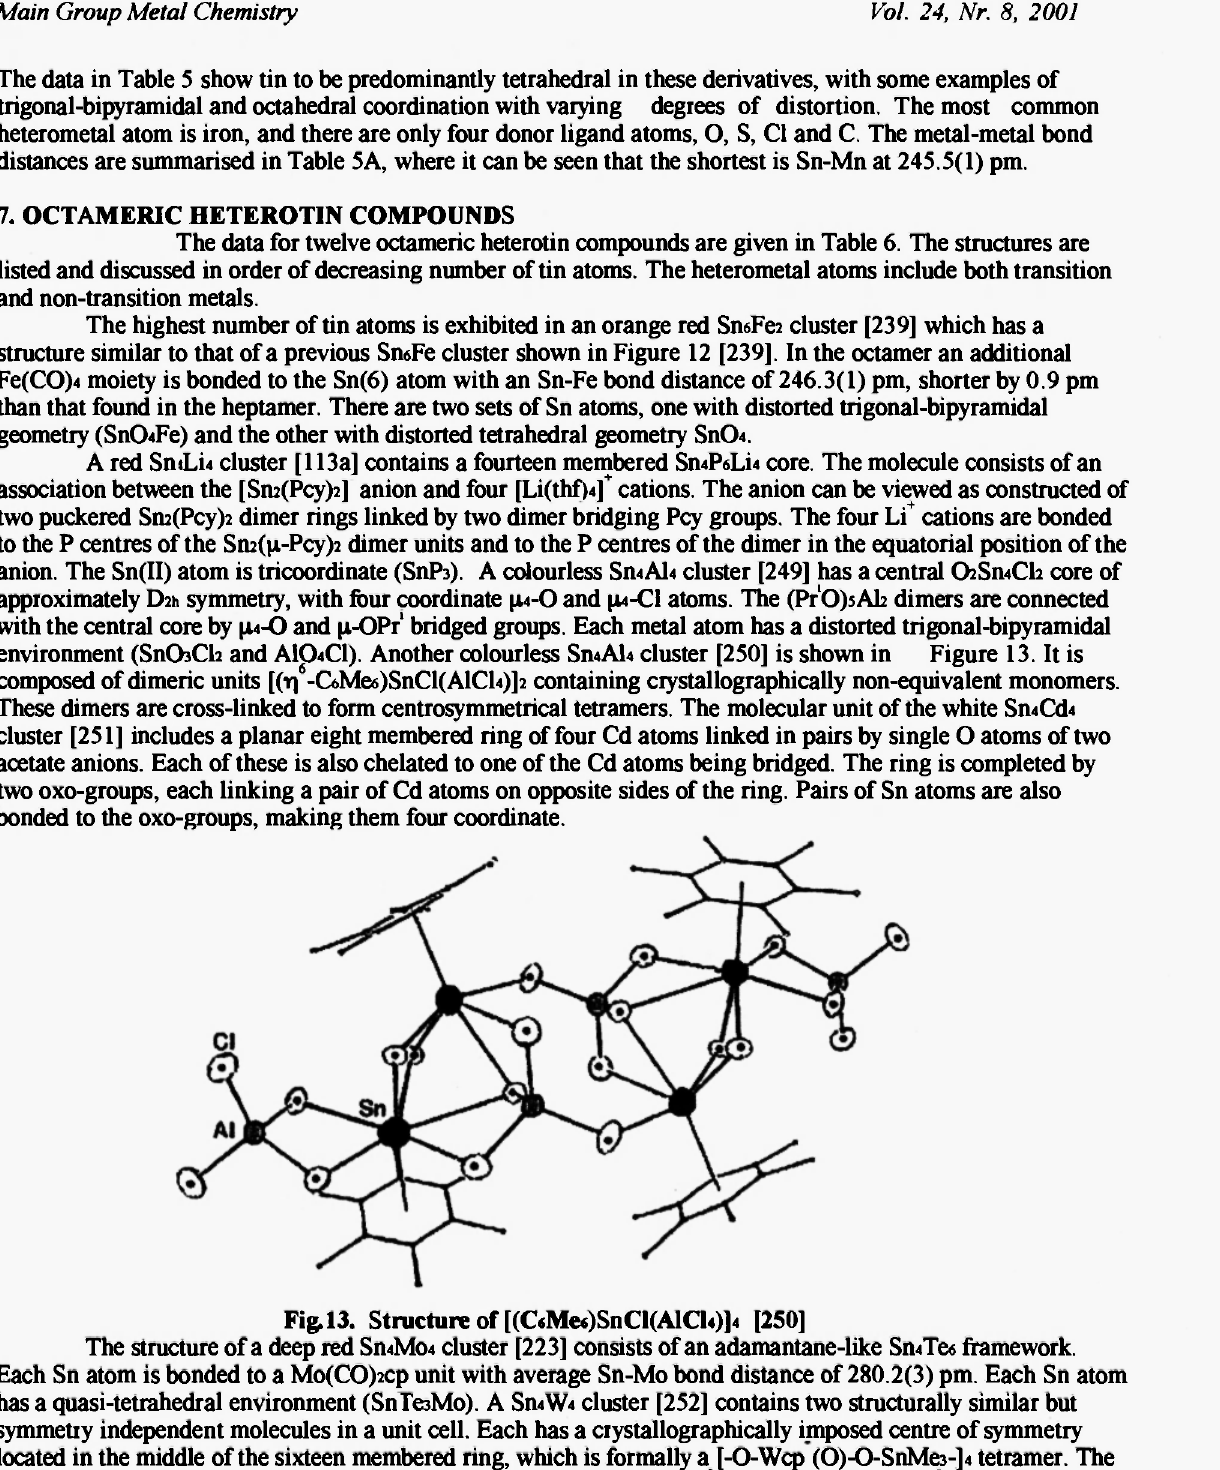
Fig. 13. Structure of [(CiMet)SnCl(AlCl«)]4